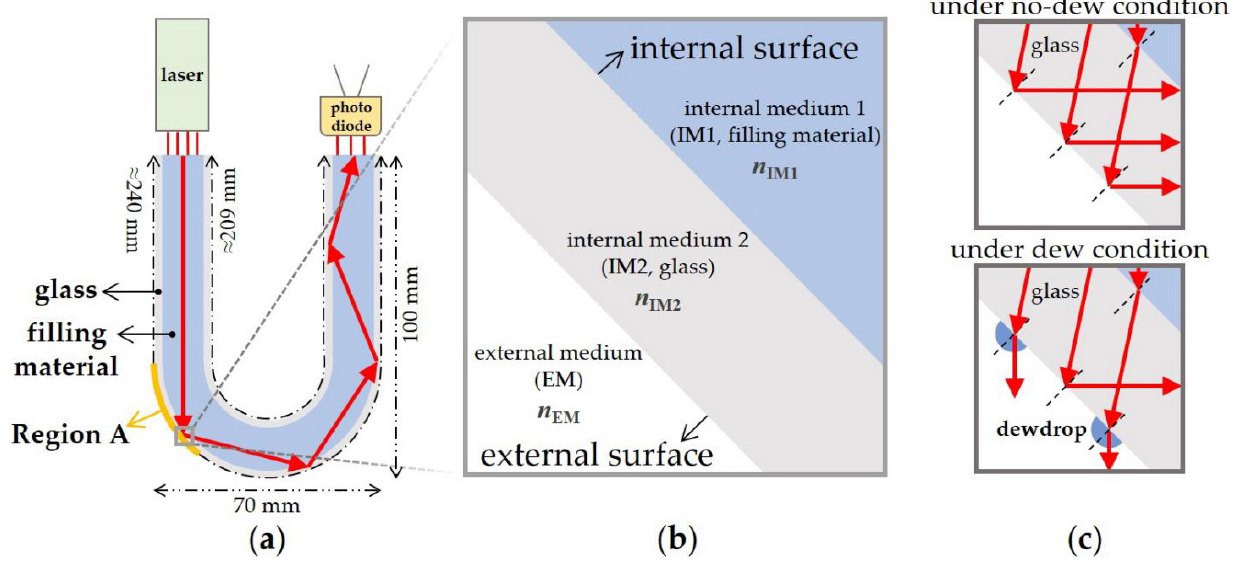
Figure 1. ( a ) Schematic diagram of the sensor, ( b ) key denotations for the constituent media and surfaces of the sensor as well as those for the absolute refractive indices of the media, and ( c ) the path difference between the incident light rays, with and without dew.